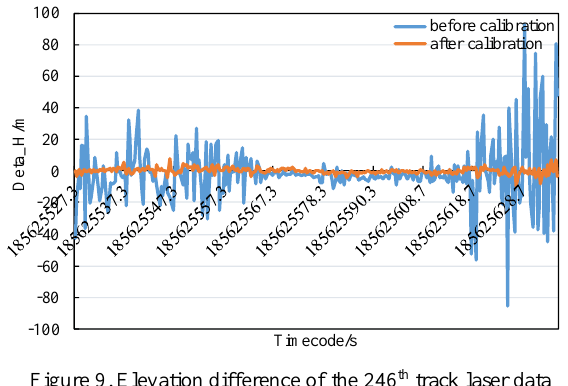
Figure 9. Elevation difference of the 246 th track laser data